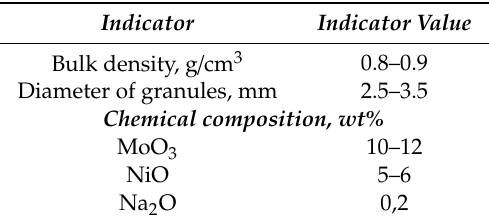
Table 1. Physical and chemical characteristics of the SGK-5